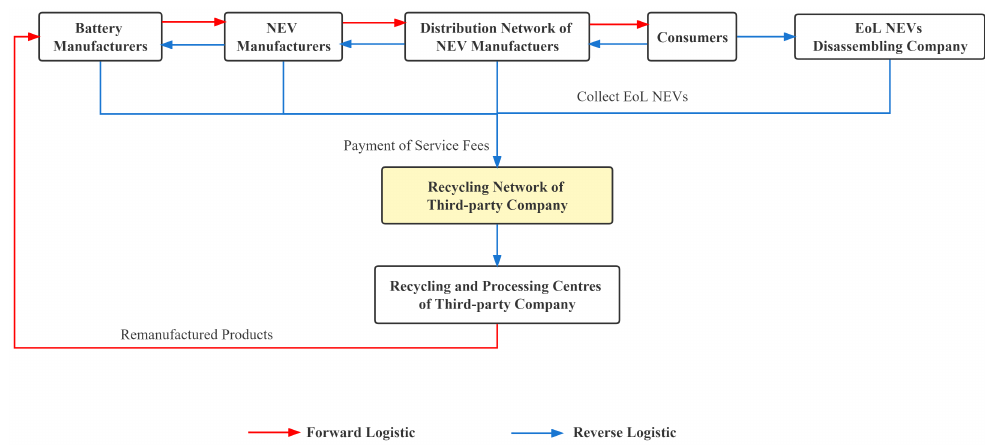
Figure 7. Third-party recycling